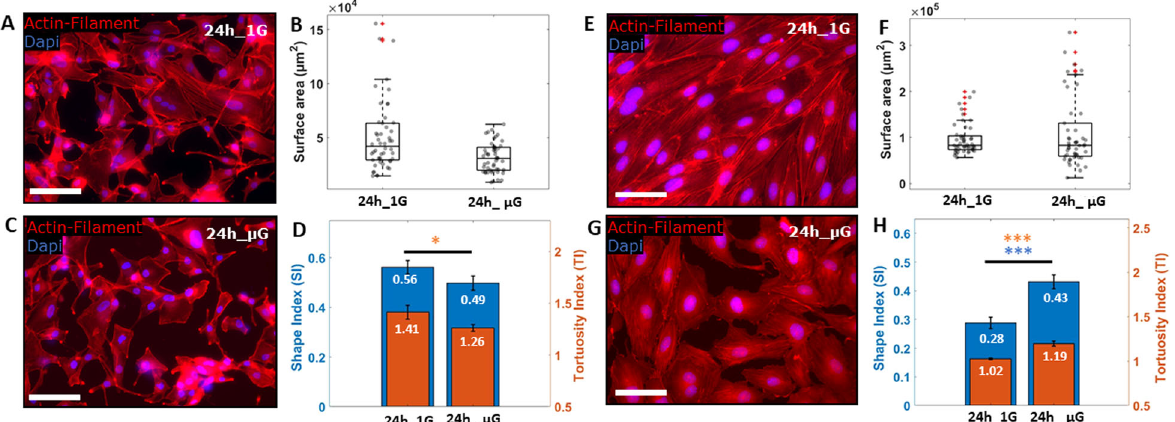
Fig. 4 Morphology evaluation. Fluorescence images of GBM and HUVEC cells, showing actin fi laments (red), VE-Cadherin (green) and DAPI (blue) after 24 h of gravity (1 G) ( A , E ) and μ G ( C , G ) conditions respectively. Box plots showing the changes of surface area ( B , F ) and histograms presenting Shape Index (SI) together with Tortuosity Index (TI) ( D , H ) for A-172 and HUVEC cells respectively, at different experimental condition. Scale bars, 100 µm. Data are shown as the mean ± SEM ( n = 50). Asterisks are reported for cases with